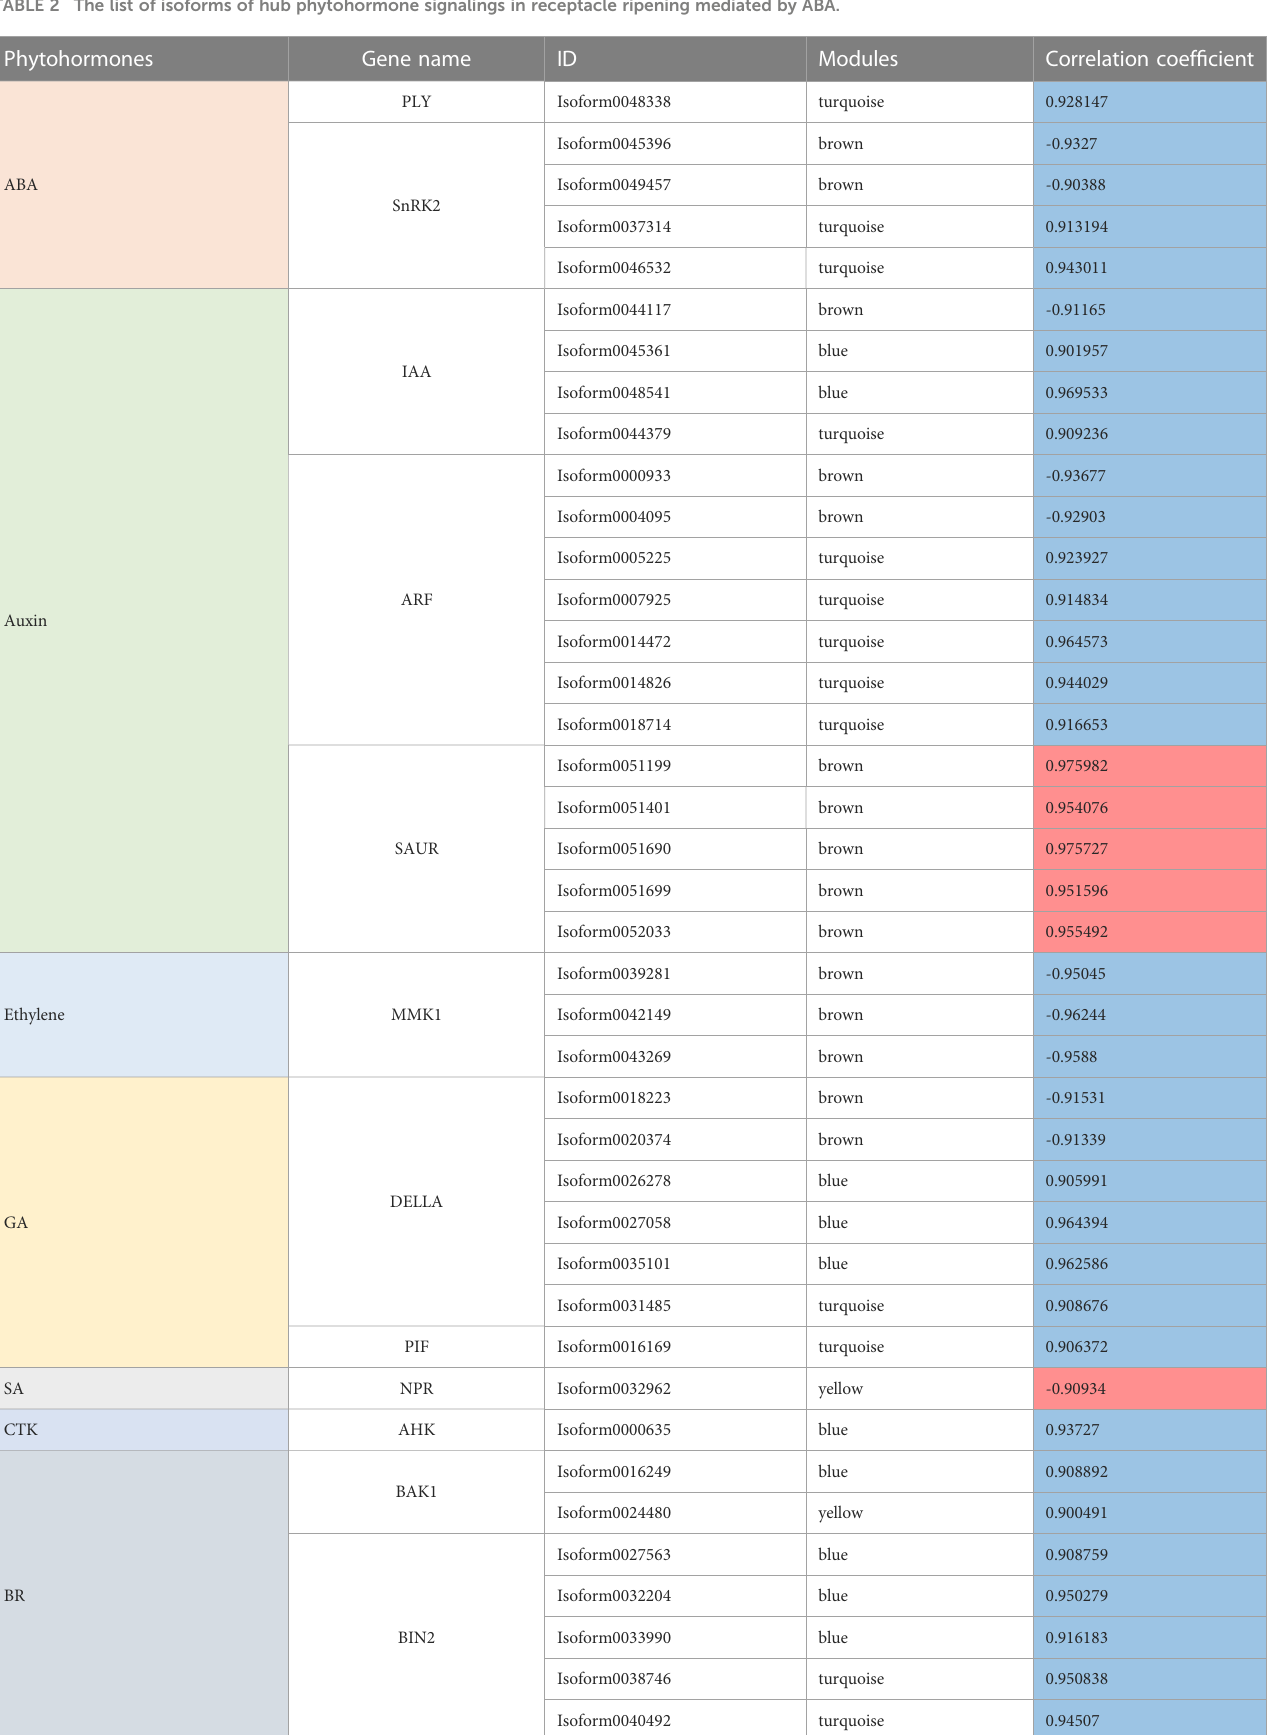
TABLE 2 The list of isoforms of hub phytohormone signalings in receptacle ripening mediated by ABA.